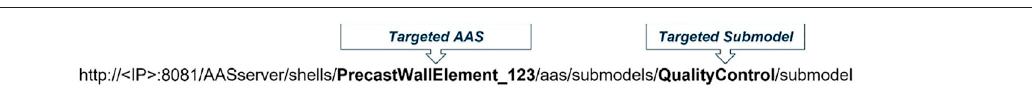
FIGURE 8 | Structure of the URL to access a speci fi c submodel.